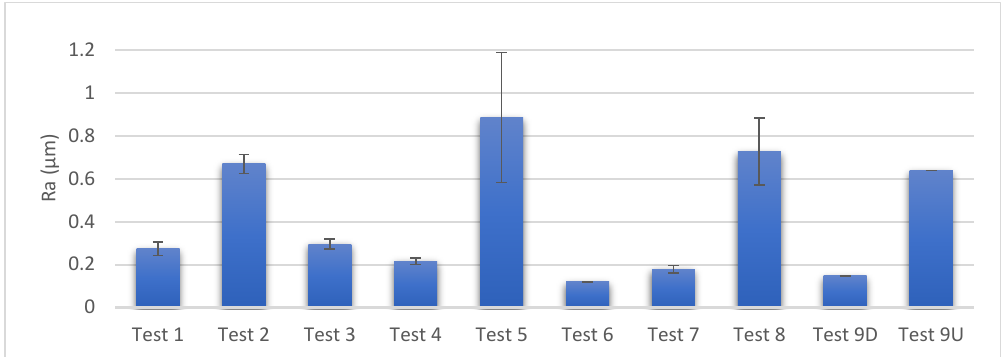
Figure 8. Graph of roughness results.